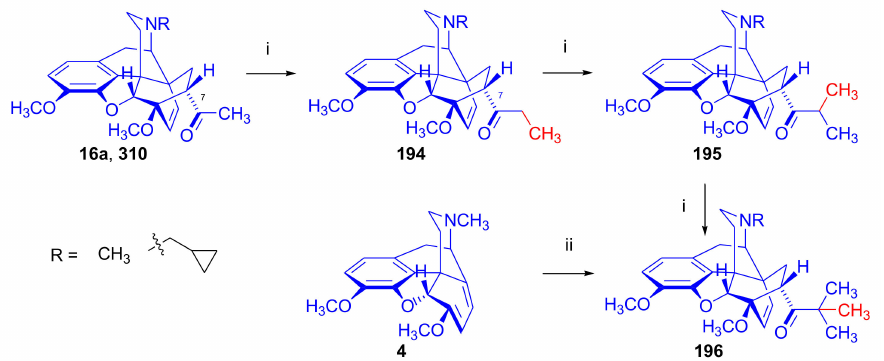
Figure 52. Methylation of the enolate of thevinone and its N 17 -cyclopropylmethyl analogue. Reagents and conditions : (i): (1) 1 equiv. n -butyl lithium, 1.5 equiv. diisopropylamine, THF, − 78 ◦ C,